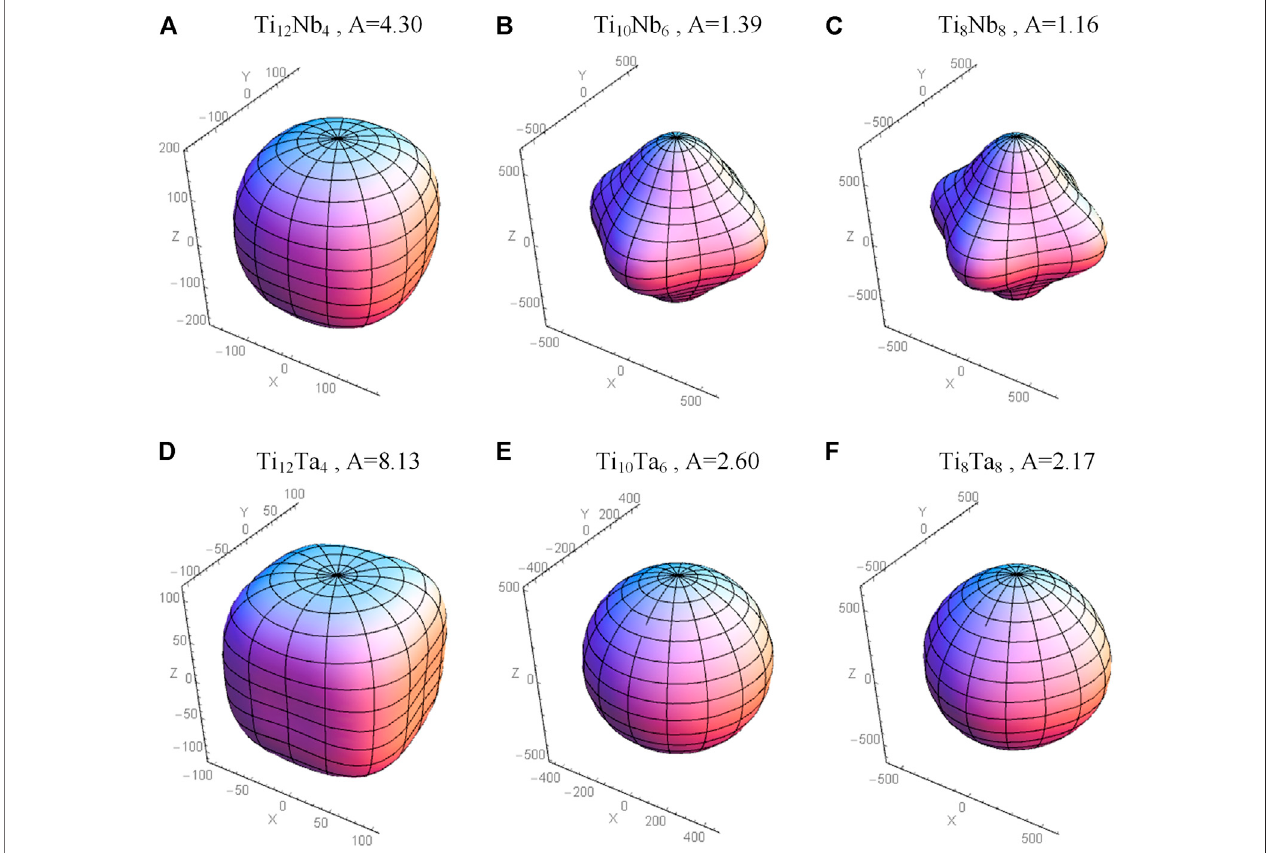
FIGURE8| Young ’ smoduliof (A) Ti 12 Nb 4 , (B) Ti10Nb6, (C) Ti8Nb8, (D) Ti12Ta, (E) Ti10Ta,and (F) Ti8Ta8.(TheZenerratio A (cid:1) 2 C 44 / ( C 11 − C 12 ) isameasure of the elastic anisotropy.)